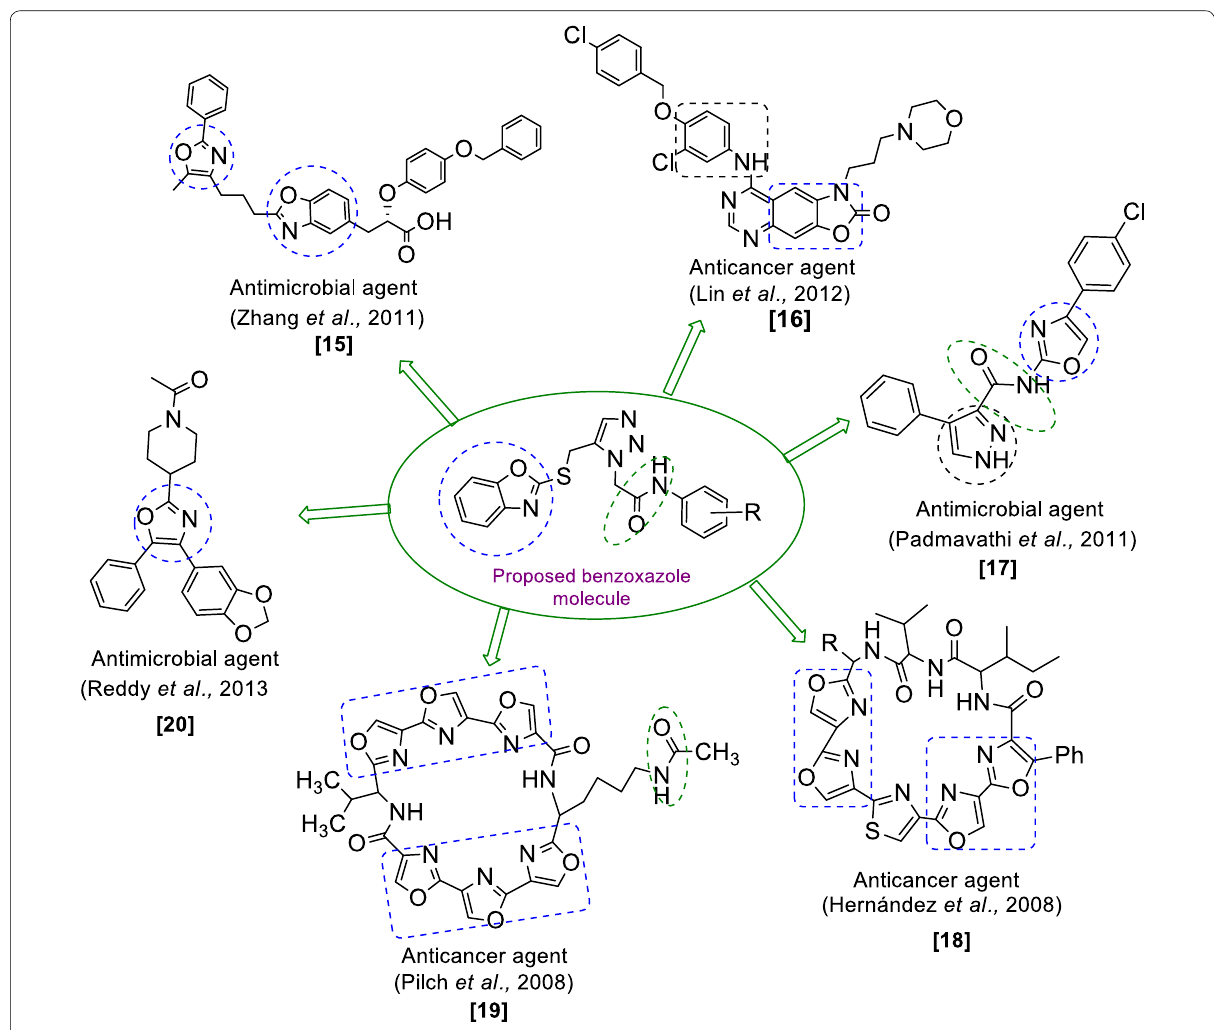
Fig. 1 Design of benzoxazole molecules for antimicrobial and anticancer potential based on